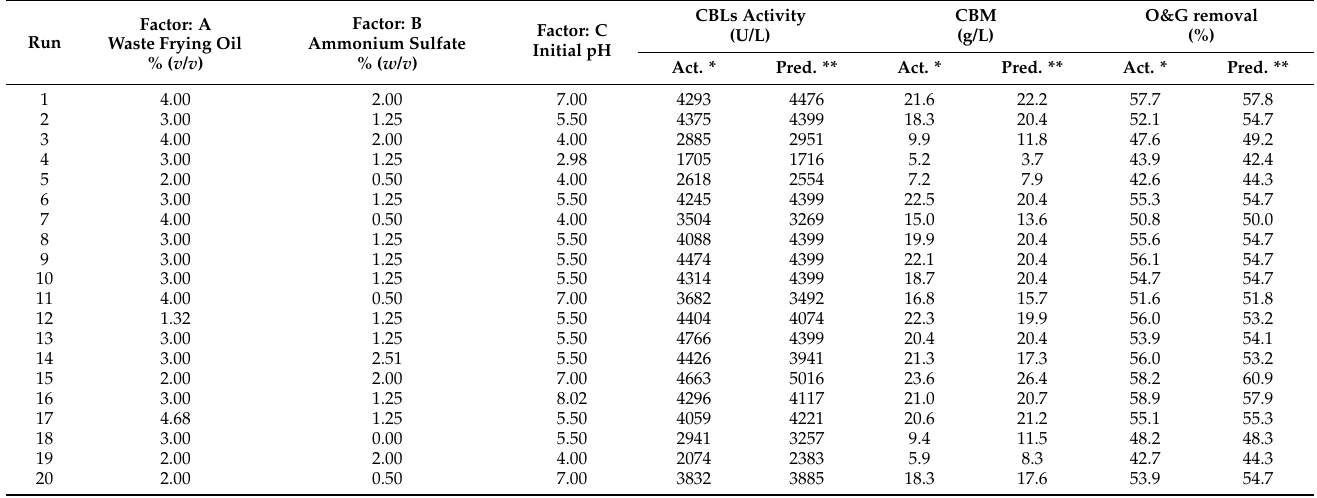
Table 4. RSM-CCD matrix with actual and predicted values of the CBLs, CBM, and O&G removal by the co-culture of M. spicifer AW2 and S. hominis AUP19 in blended oily wastes